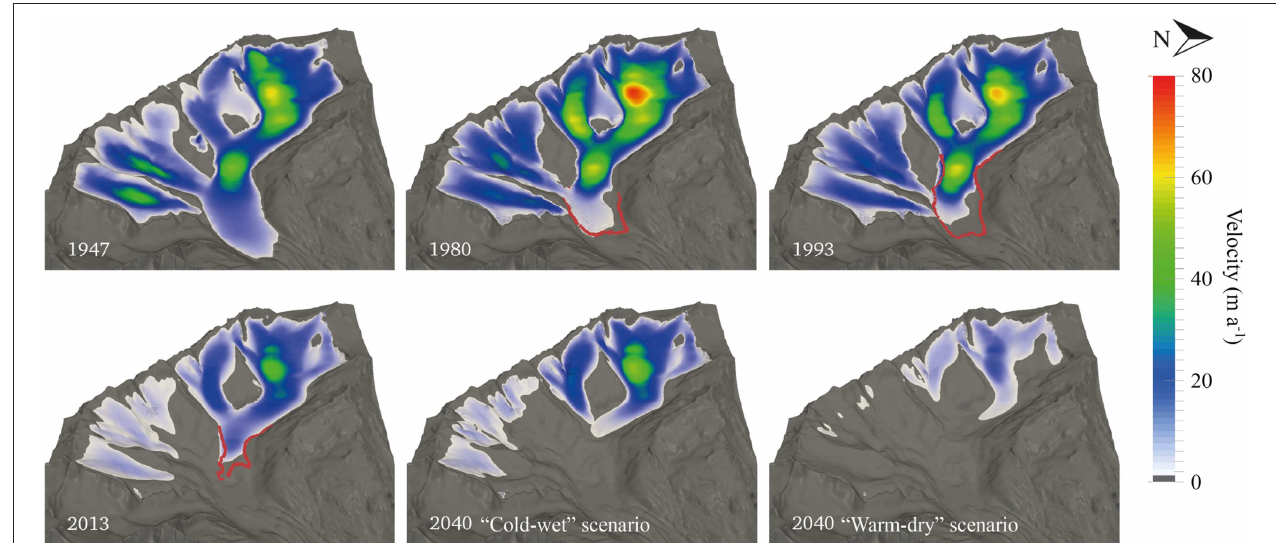
FIGURE 3 | Modeled velocity and ice extent of Gauligletscher between 1947 and 2040. The results of both climatic scenarios in 2040 are shown. The red lines indicate the observed glacier extent.